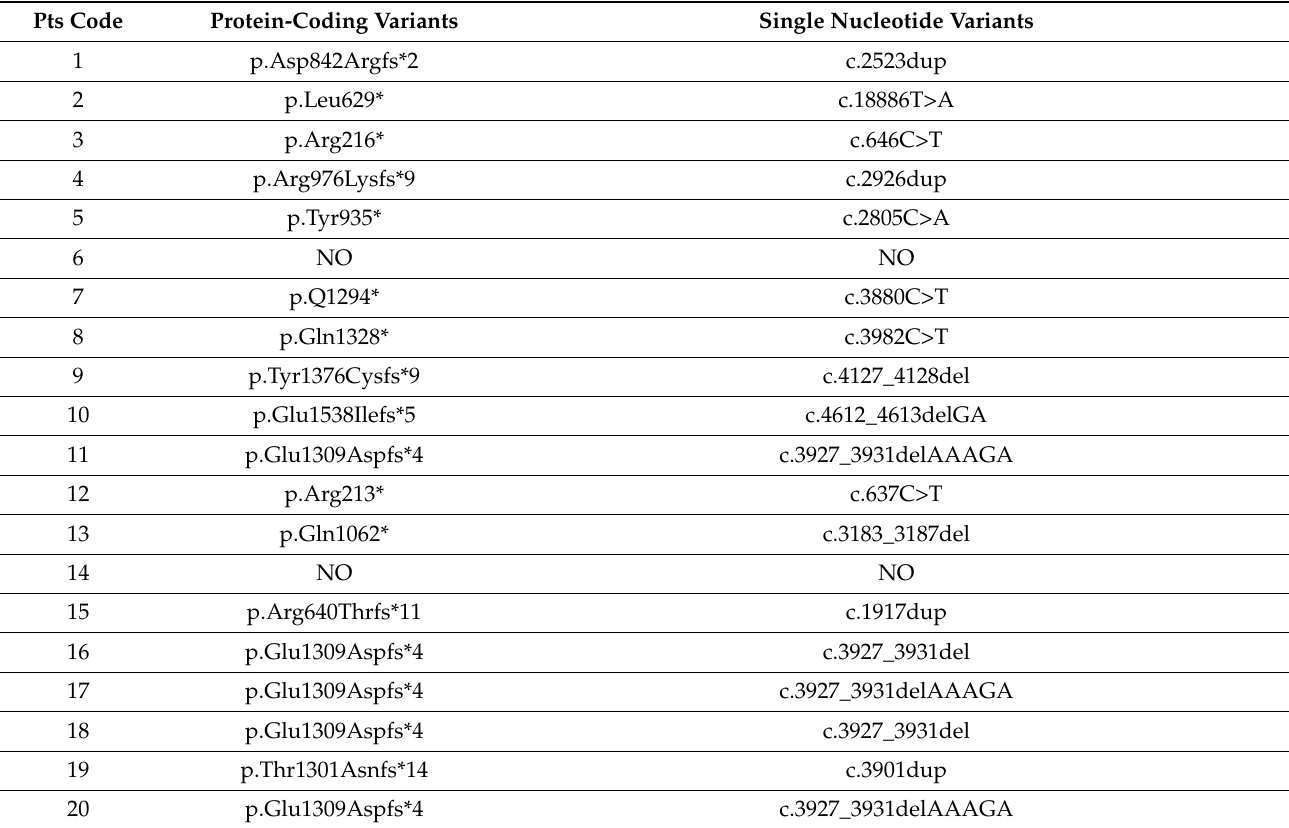
Figure 1. Patient-level heatmap. Representation of the genetic, baseline, and rectal stump main surgical details of the considered 47 patients. Table 1. Genotype information of the 47 patients who developed a rectal cancer.